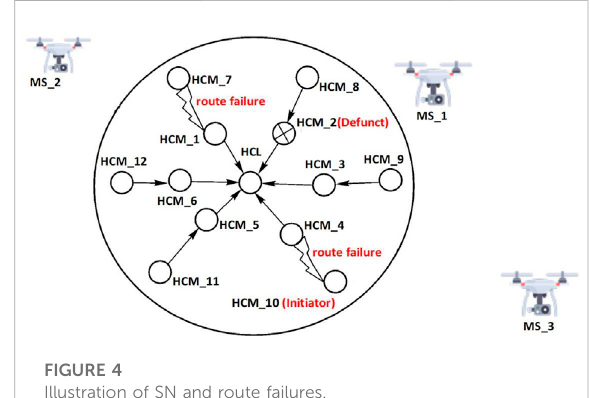
FIGURE 4 Illustration of SN and route